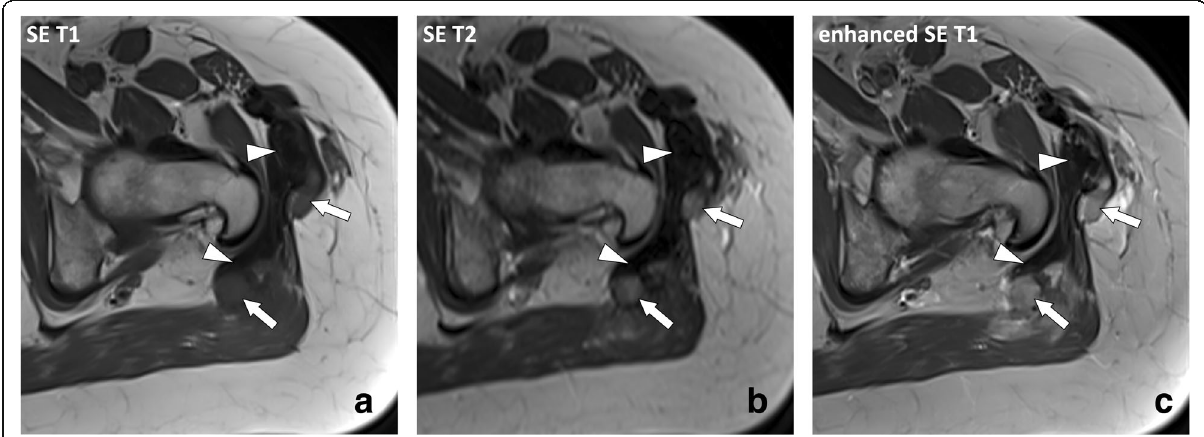
Fig. 15 Axial ( a ) SE T1w image before contrast material injection, ( b ) SE T2w image, and ( c ) SE T1w image after contrast material injection of the left hip of the same patient as in Fig. 14. Masses have heterogenous signal reflecting their histological content: “ mature ” inactive fibrosis has low signal intensity and no enhancement (arrowheads) while “ immature ” active fibrosis has intermediate signal on T1w images and high signal intensity on T2w images with enhancement after contrast material injection (arrows)